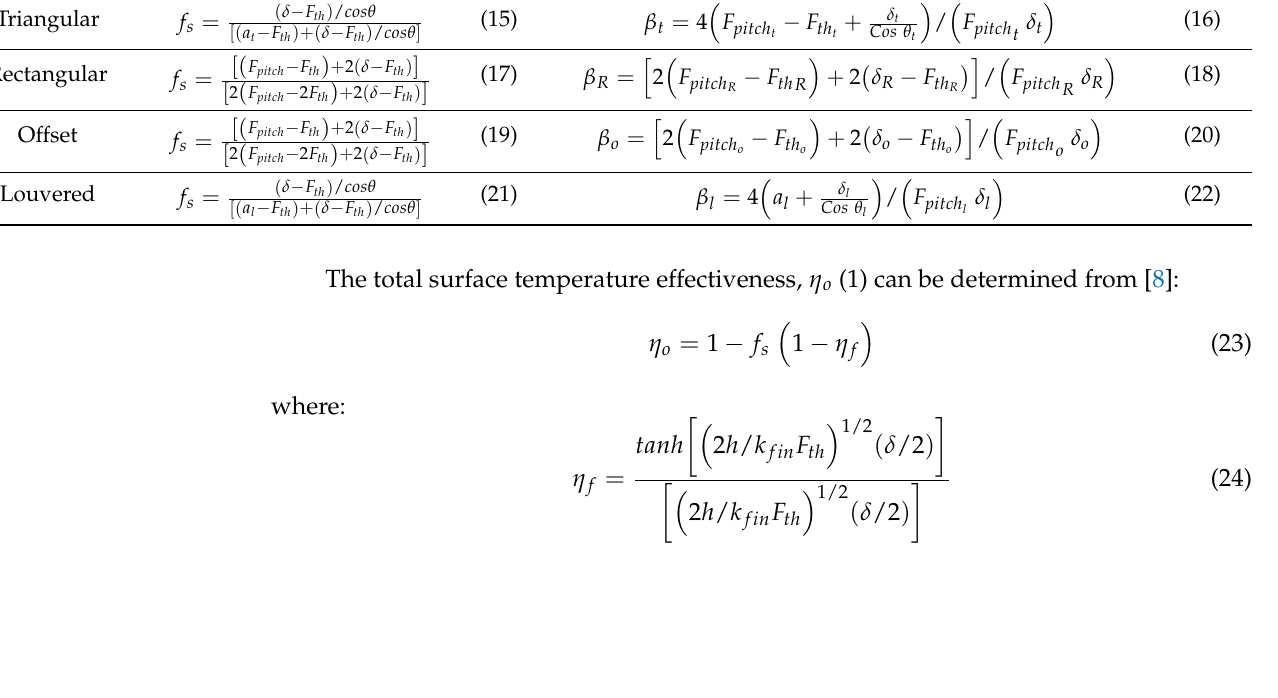
Table 2. Ratio of secondary surface of total area and area density for triangular, rectangular, offset, and louvred surfaces. Surface